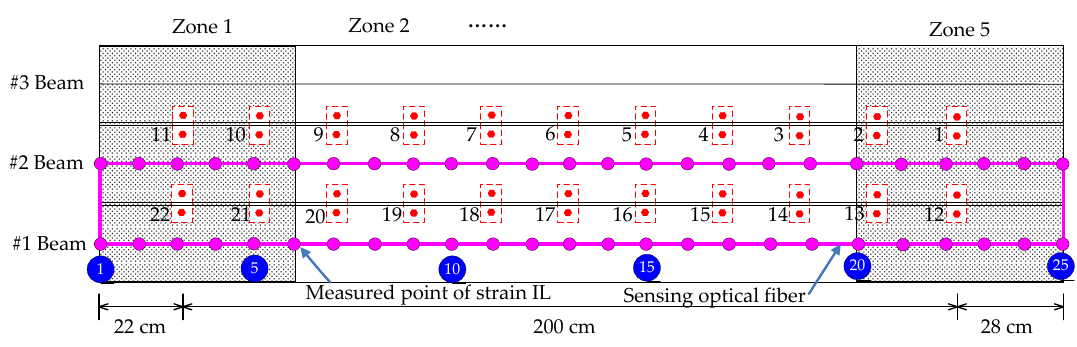
Figure 18. Placement of the sensing optical fiber and devices simulating the damage of the transverse connection.